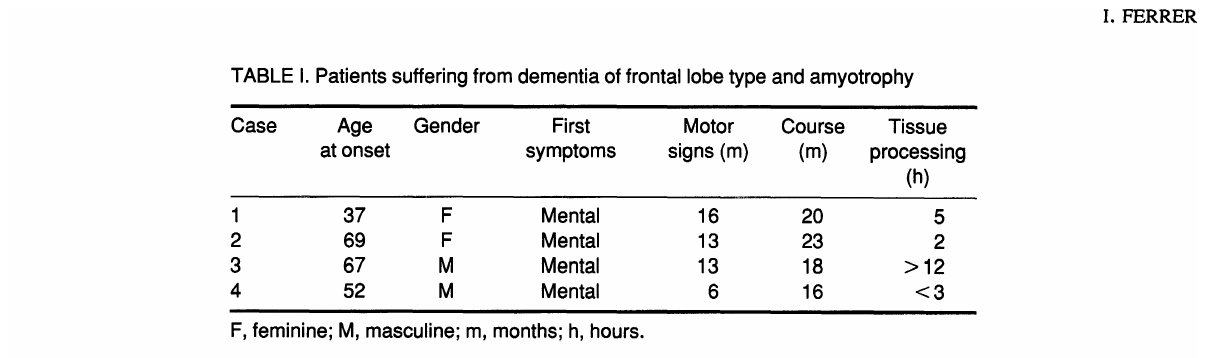
TABLE I. Patients suffering from dementia of frontal lobe type and